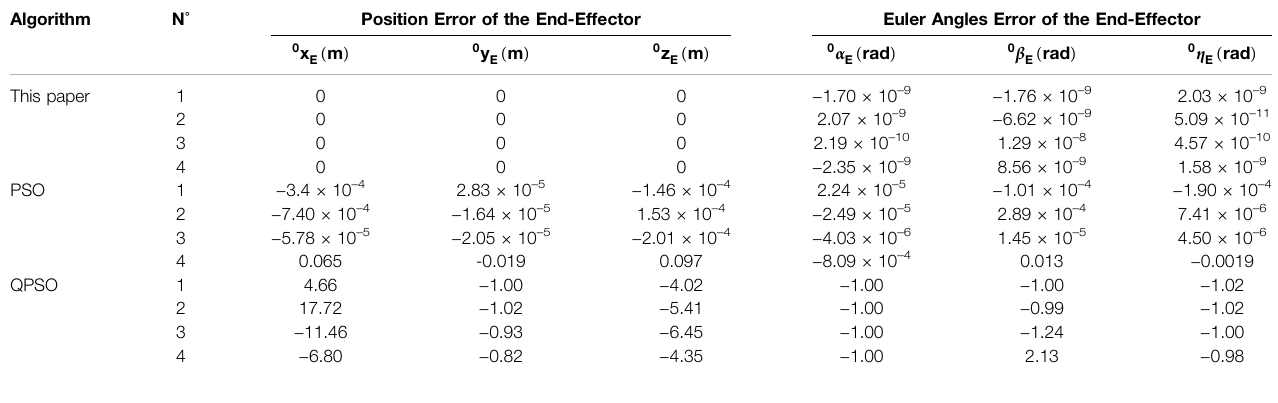
TABLE 8 | The errors in position and Euler angles of impact points by different